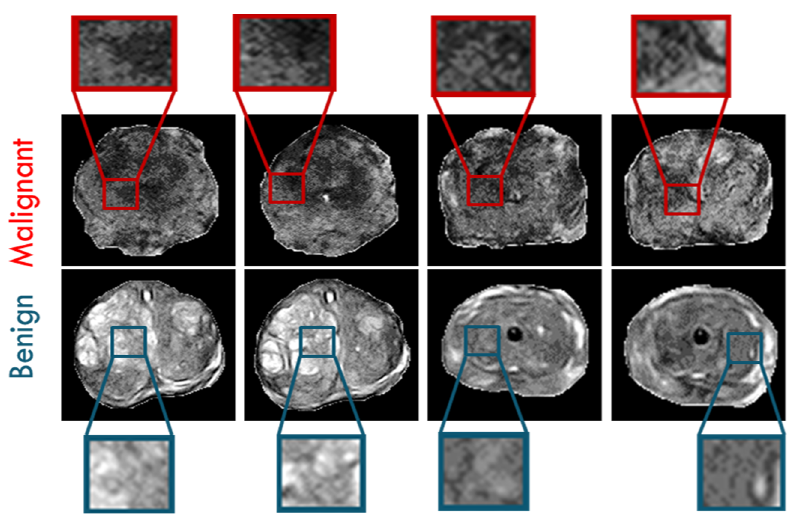
Figure 4. Illustrative examples of prostatic texture differences showing high gray level heterogeneity in four different malignant cases (first row) and low gray level heterogeneity in four different benign cases (second row).